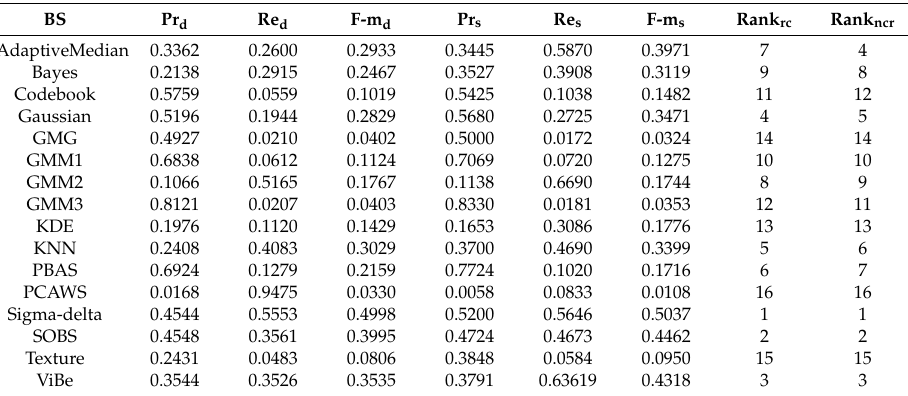
Table 9. Evaluation metrics and rank-orders of the evaluated BS algorithms.